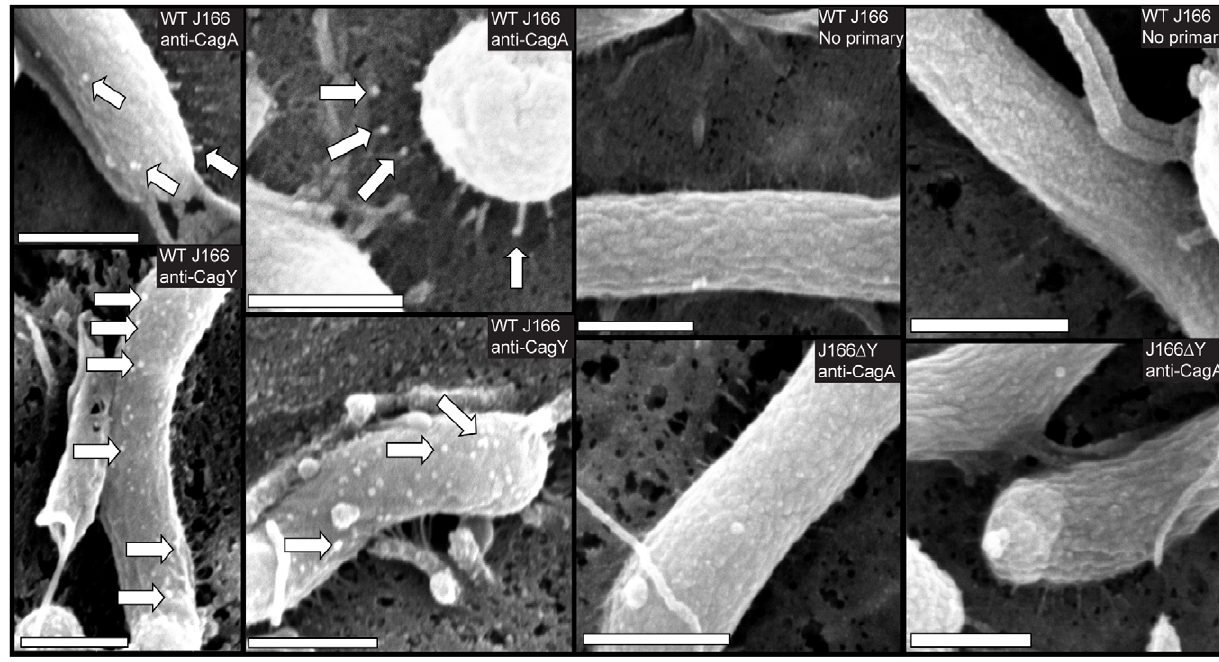
Figure 8. CagY decorates the H.pylori bacterial surface but is not associated with T4SS pili. H. pylori was co-cultured with AGS gastric cells at an MOI of 100:1, incubated with antibodies to the CagY MRR or CagA, and imaged by FEG-SEM in the environmental mode. CagY was detected on the bacterial surface of the WT strain but was not associated with pili. CagA was detected both on the bacterial surface and in close approximation to the tips of the pili of the WT strain. There was markedly reduced CagA labeling on the surface of n cagY mutant strain compared to the WT strain. No staining was seen when primary antibody was omitted. Pili are sometimes not as well visualized and more often appear broken in these images compared to Figure 7 due to the lack of metal coating and more frequent washes. Magnification bars indicate 500